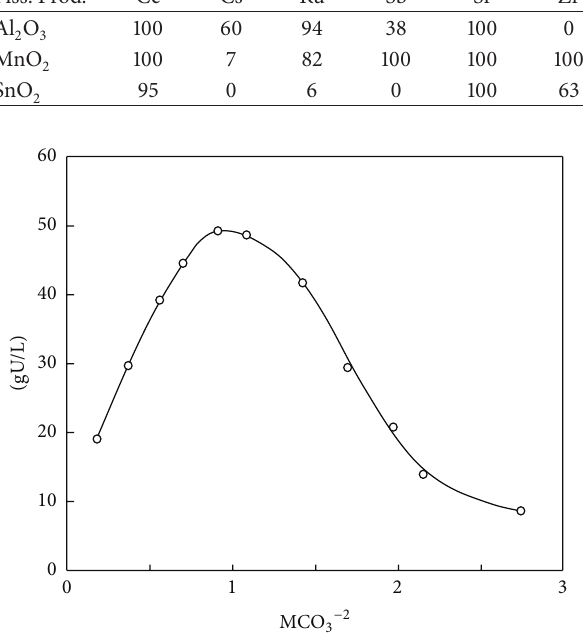
Figure 6: Dissolution of ammonium diuranate at varying CO 3−2